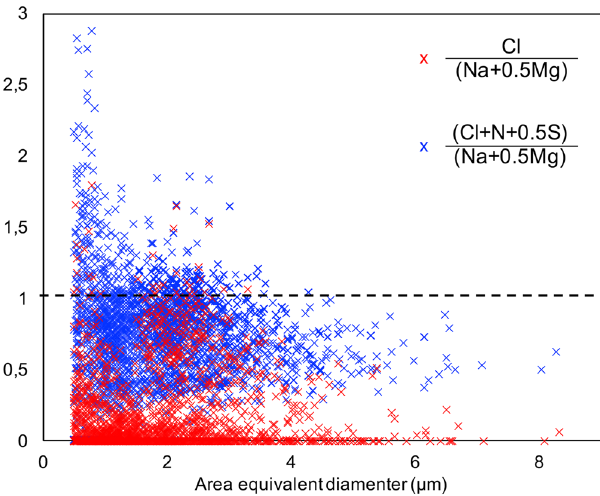
Fig. 3 Evaluation of sea salt aging process. The elemental composition of bulk particles was determined with CCSEM/EDX for all particles (2022) assigned as “ sea salt ” (See Supplementary Fig. 1); the ratios of Cl/(Na + 0.5Mg) were calculated, where the dashed line indicates the characteristic ratio of unprocessed (i.e., fresh) sea salt particles. The values of (Cl + N + 0.5 S)/(Na + 0.5Mg) correspond to aged sea salt particles with chloride quantitatively displaced by only nitrate and sulfate.